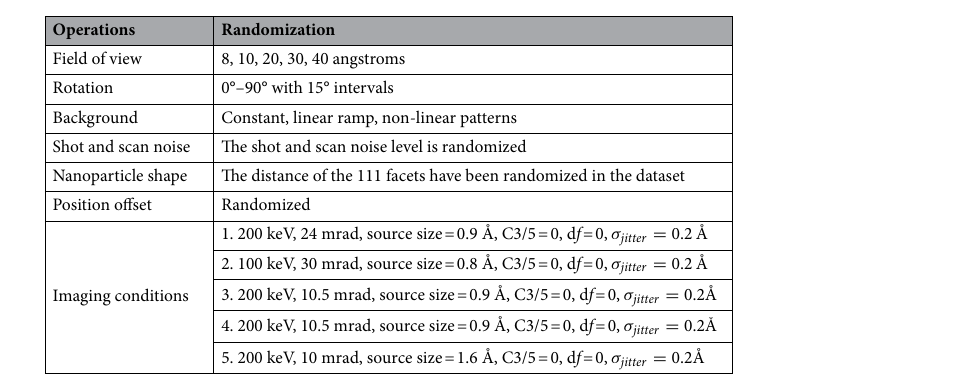
Table 1. Augmentation